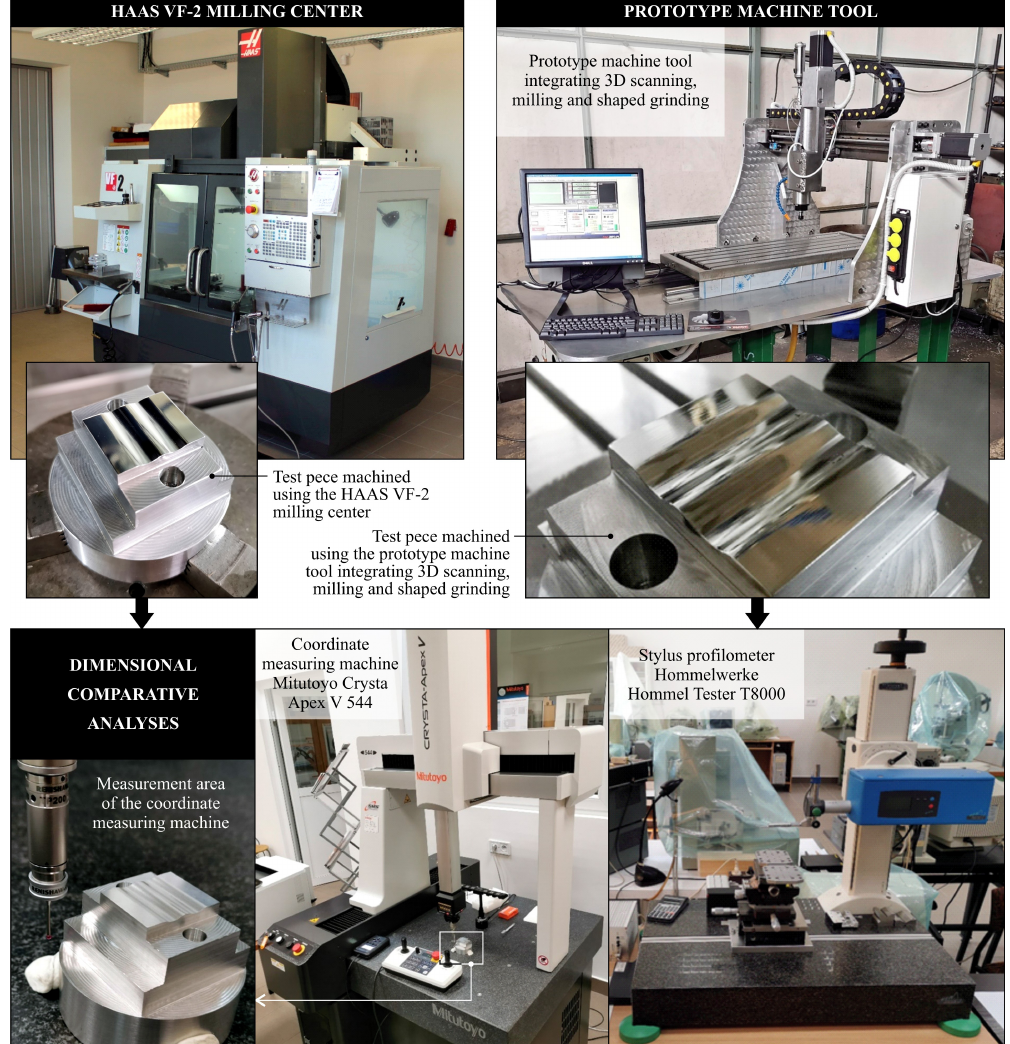
Figure 4. Methodology for comparative analyses of the accuracy of dimensions, shapes, and surface textures of test pieces machined using two machining machine tools.